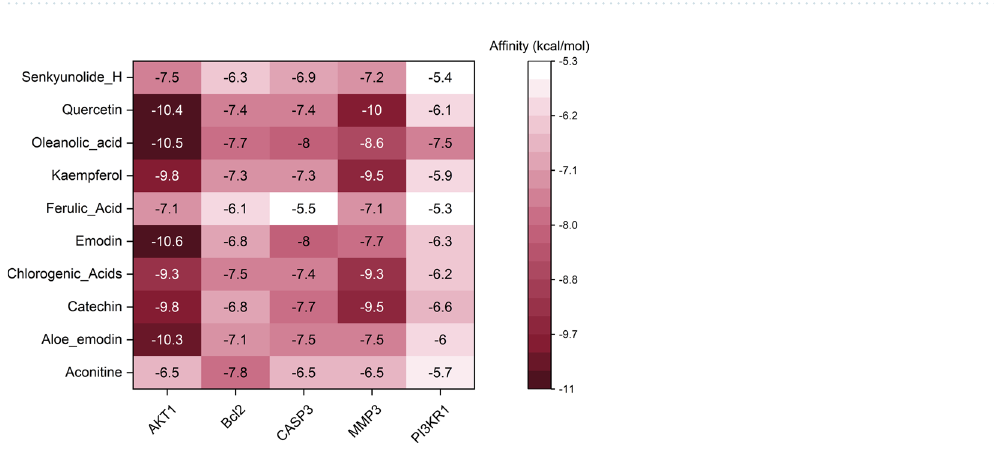
Figure 6. Molecular docking scoring